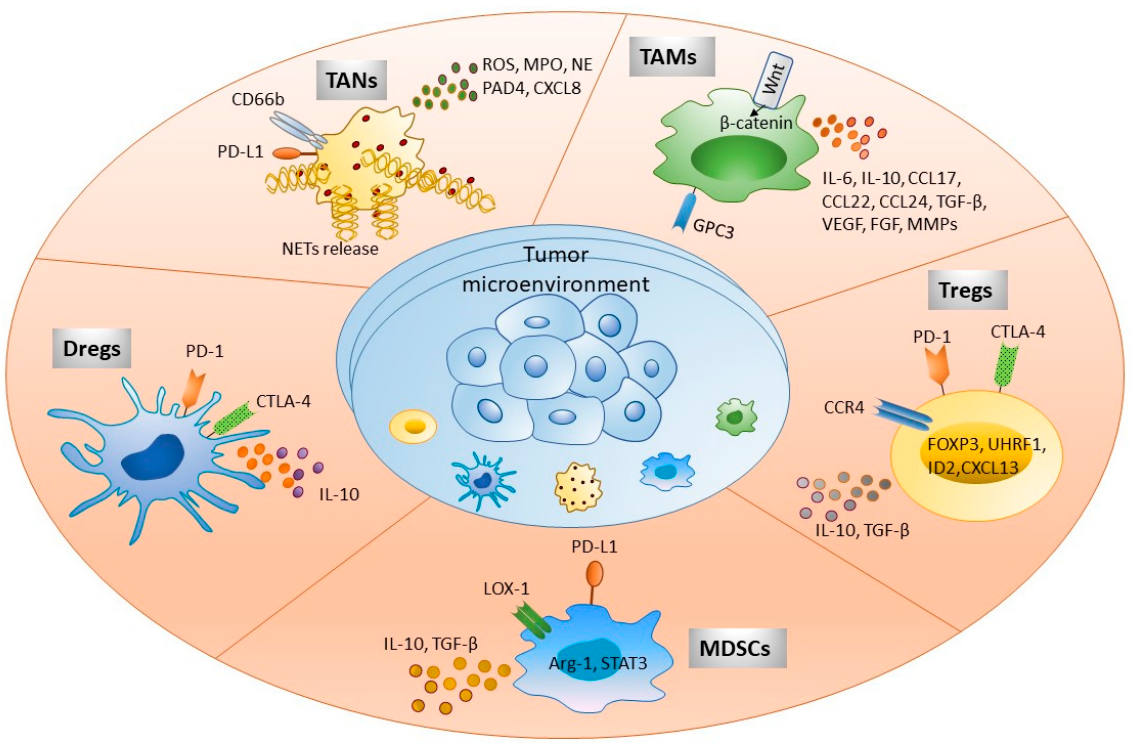
Figure 1. Immune cells present in tumor microenvironment participate in HCC development. Tumor immune microenvironment exhibits various immune cells as shown in the figure. These cellular populations interact with other parenchymal, nonparenchymal, and tumor cells directly by expressing different cell surface molecules or via secretory factors, such as cytokines, chemokines, and other soluble factors. This complex cellular interplay significantly participates in immune escape, tumor invasion, and metastasis. Targeting these molecules serves as a potential immunotherapeutic strategy to treat HCC patients. Abbreviations: FOXP3, Forkhead box protein 3; ROS, Reactive oxygen species; MPO, Myeloperoxidase; NE, Neutrophil elastase; PAD4, Protein-arginine deiminase type 4; NETs, Neutrophil extracellular traps; GPC3, Glypican 3; ILs, Interleukin; CCL and CXCL, Chemokine ligand; TGF- β , Transforming growth factor- β ; VEGF, Vascular endothelial growth factor; FGF, Fibroblast growth factor; MMPs, Matrix metalloproteinases; CTLA-4, Cytotoxic T lymphocyte antigen 4; CCR4, Chemokine receptor 4; LOX-1, Lectin-like oxidized low-density lipoprotein (LDL)